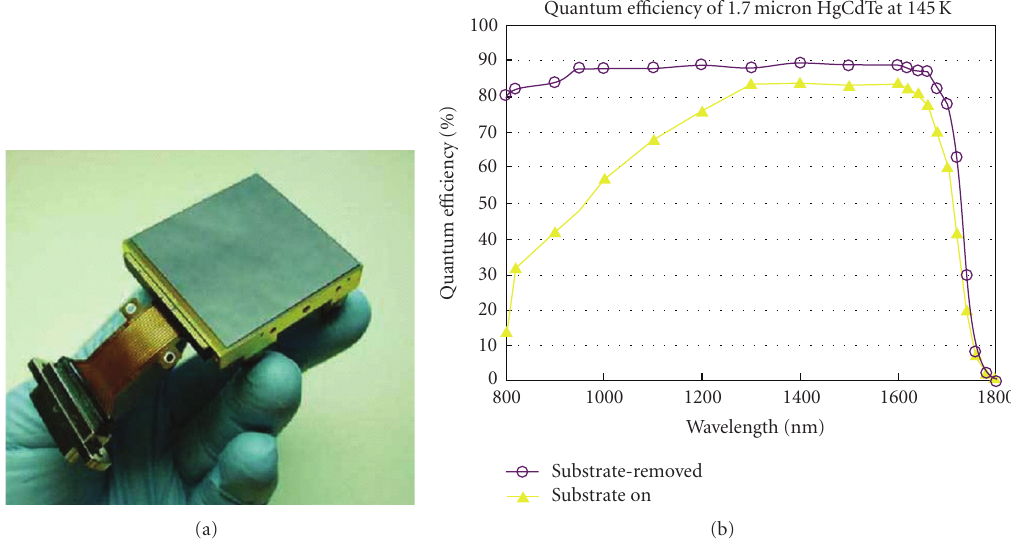
Figure 14: The Hawaii-2RG IR array from Teledyne and the predicted QE for 1.7mm cut-o ff wavelength. With the substrate removal, the QE curve extends toward the visible domain